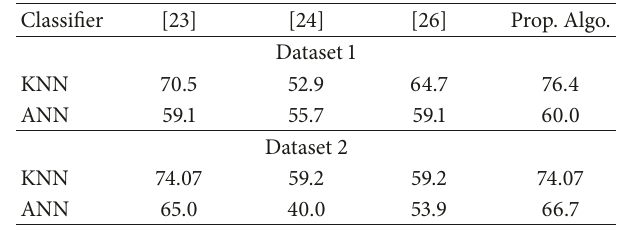
Table 2: Accuracy for 75 and 25 percent training and testing data. Classifier